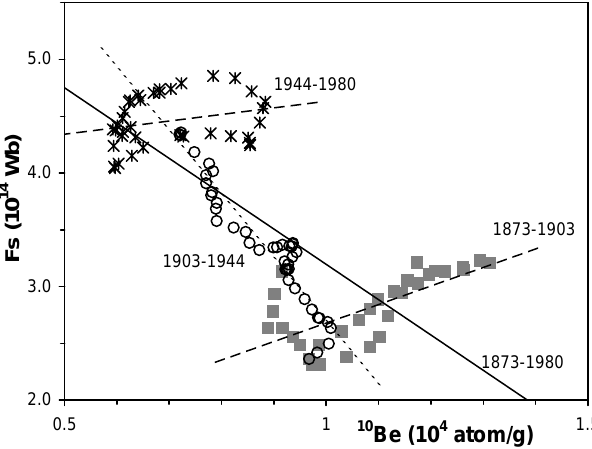
Fig. 3. Scatter plot of annual 11-year running mean values of F s vs. 10 Be concentration for 1873–1980. Solid line represents the best linear regression for the entire period while squares and dashed line, open circles and dotted line, and asterisks and dashed line depict points and the best linear regression for 1873–1903, 1903–1944 and 1944–1980,